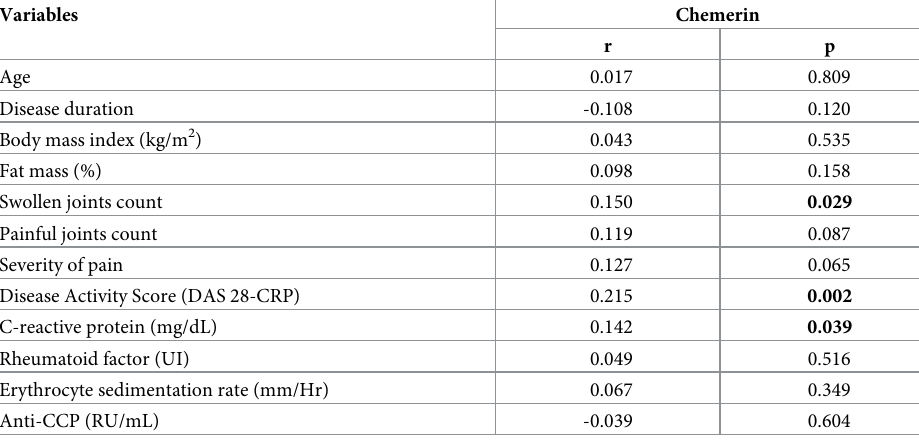
Correlations were obtained using the Pearson correlation test. Abbreviations: Anti-CCP: Anti-Cyclic Citrullinated